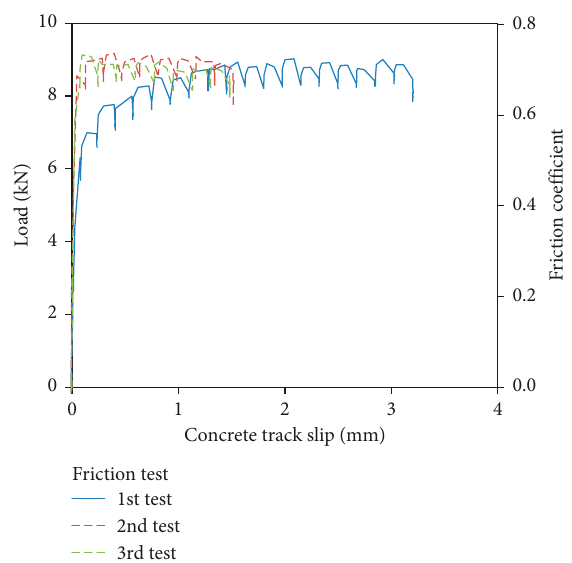
Figure 10: Load-slip response from the friction